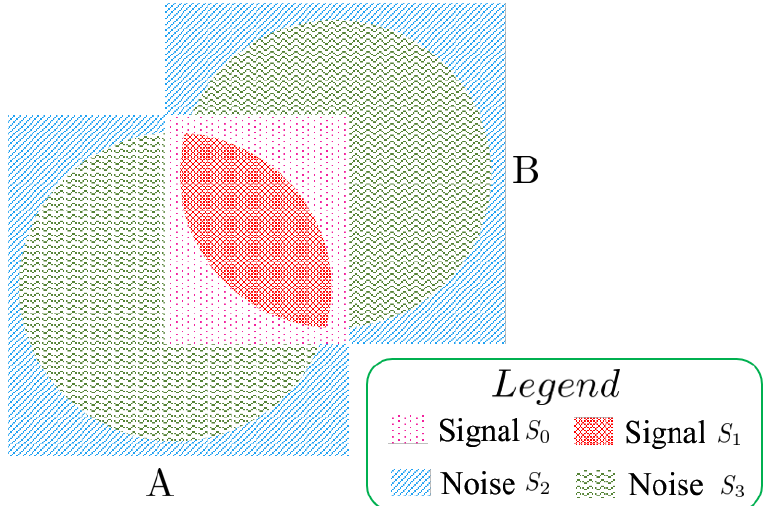
Figure 6. A , B represent two images, respectively. There exist displacements between them. Their corresponding weighted filtering window is denoted by a circle and centered at the image. Signal S 0 denotes the information in the overlap and suffered from the degradation due to the filtering of weighted window function. Signal S 1 denotes the information in the overlap and is free from the degradation due to the filtering of weighted window function. The difference between signal S 0 and S 1 is that one is degraded by the weighted window function and one is not. Noise S 2 denotes the information that is not in the overlap and suffered from the degradation due to the filtering of weighted window function. Noise S 3 denotes the information that is not in the overlap and is free from the degradation due to the filtering of weighted window function. The difference between noise S 2 and noise S 3 is that one is degraded by the weighted window function and one is